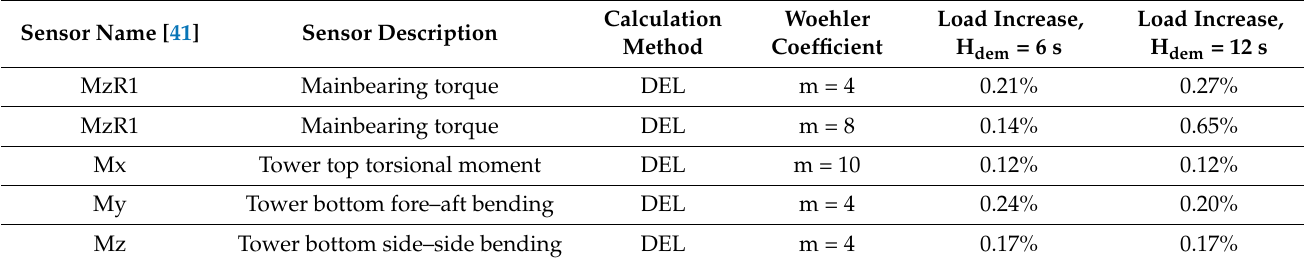
Table 4. Load changes for sensors with an increase of more than 0.1% caused by the provision of